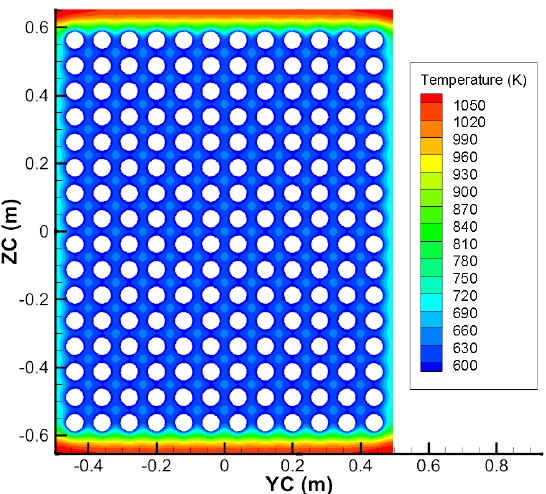
Figure 6. The temperature contour of the center plan of the BZ3.